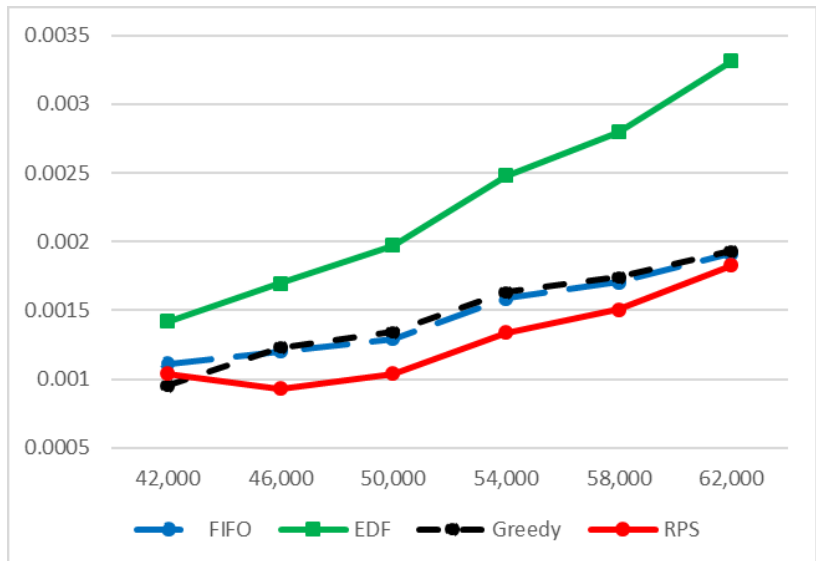
Figure 11. Processing time in seconds with different arrival rates.